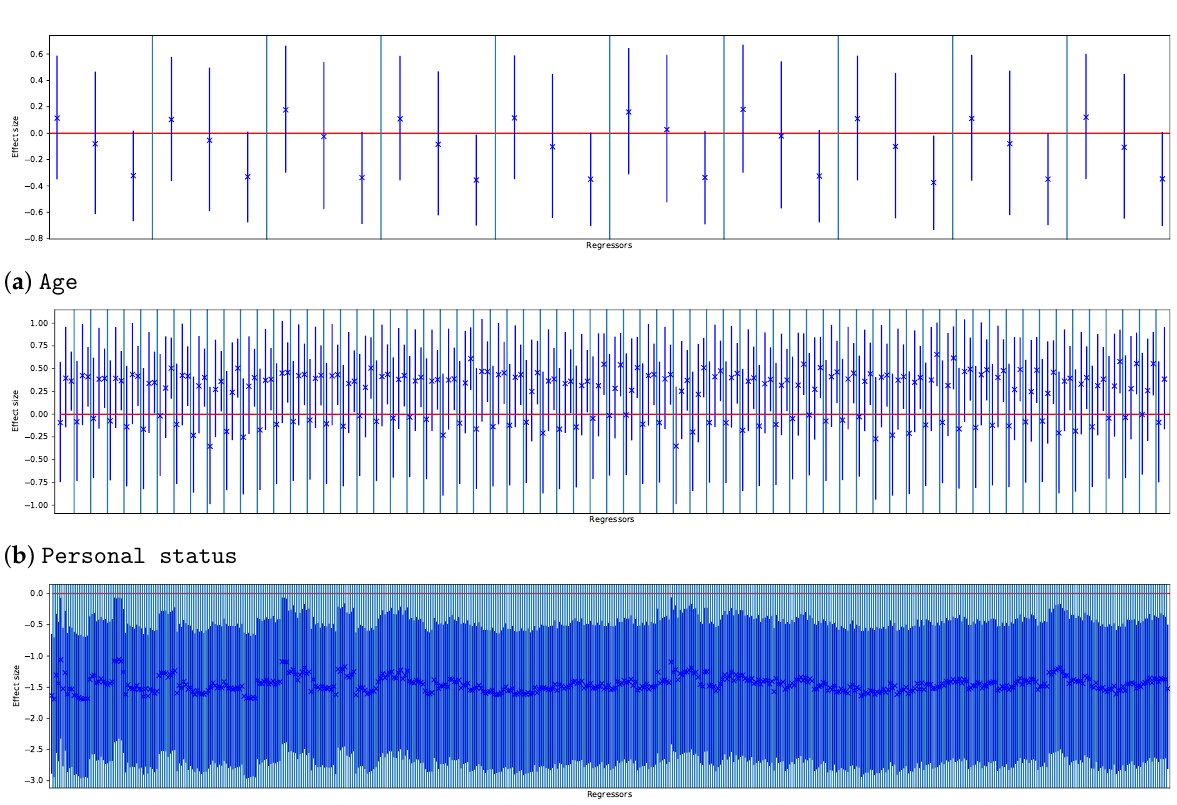
Figure 8. Coefficients confidence intervals for the three features under investigation in the experiment (support 0.09 and confidence 0.9). Variable Age can take four values: [ 0,30 ] , ( 30,41 ] , ( 41,52 ] and ( 52,100 ] . The baseline value used in the regression model is ( 30,41 ] . Variable Personal status can take four values: male _ single , female _ div _ or _ dep _ or _ mar , male _ div _ or _ sep and male _ mar _ or _ wid . The baseline value used in the regression model is female _ div _ or _ dep _ or _ mar . Variable Foreign worker can take two values: Y , N . The baseline value used in the regression model is N